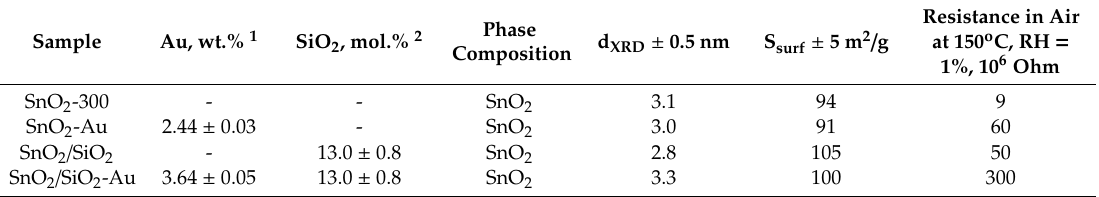
Table 2. Composition, microstructure parameters and electrophysical properties of the obtained samples.